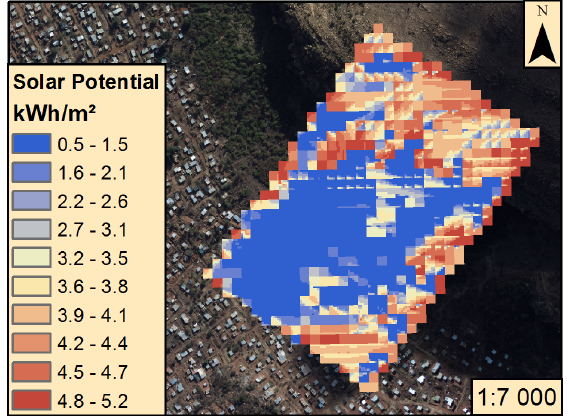
Figure 10. Solar radiation model for Alaska derived from the 10m DSM Deriving a solar radiation model from the 30m DEM is not